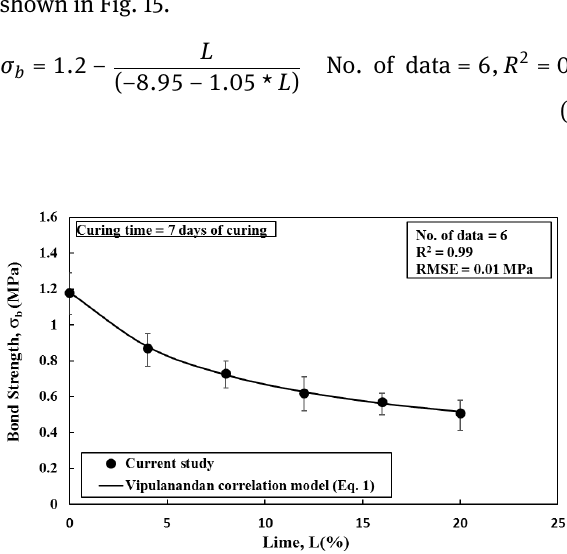
Figure 14: Relationship between percentage of Lime and tensile bonding strength of cement mortar at 7 days of curing